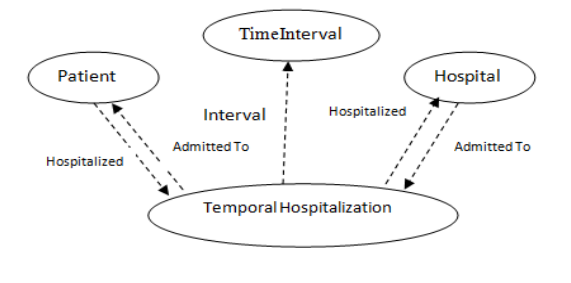
Figure 5. Example of “n-ary